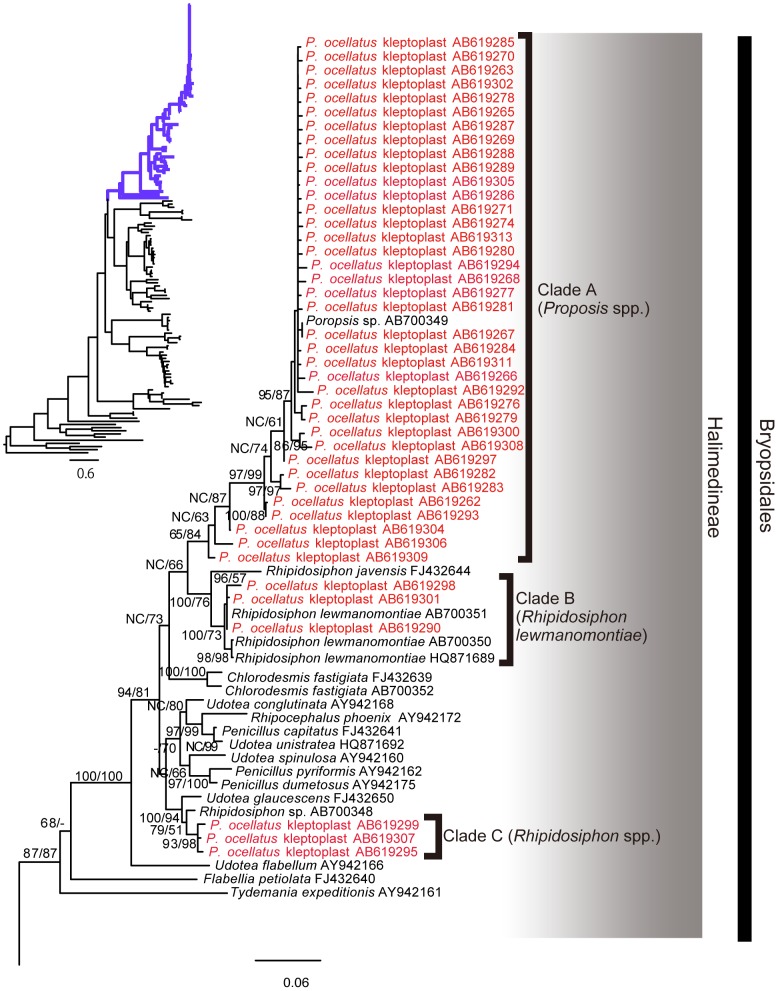
Phylogenetic tree based on rbcL sequences.Maximum likelihood (ML) phylogeny of the class Ulvophyceae based on 1254 nucleotide positions of the chloroplast-encoded rbcL gene. The phylogram of the entire tree on the upper left is colored to match the inset. Chlamydomonas reinhardtii (class Chlorophyceae) was chosen as the outgroup. Red, rbcL sequences from P. ocellatus. Black, algal rbcL sequences. Bootstrap support (BS) values >50% are provided at the nodes (neighbor-joining/ML). “-“, BS <50%; “NC”, nonconsensus node that was not observed in the neighbor-joining tree.